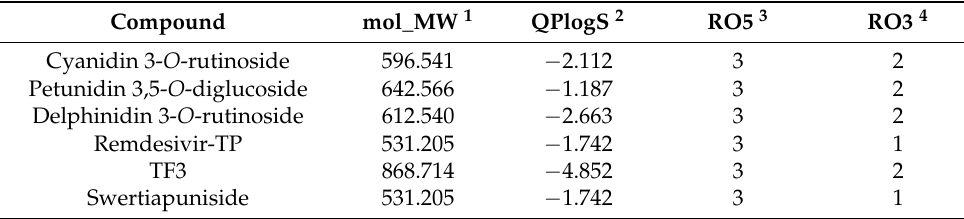
Table 3. Selected Qikprop descriptors of the top three polyphenols and the control compounds.